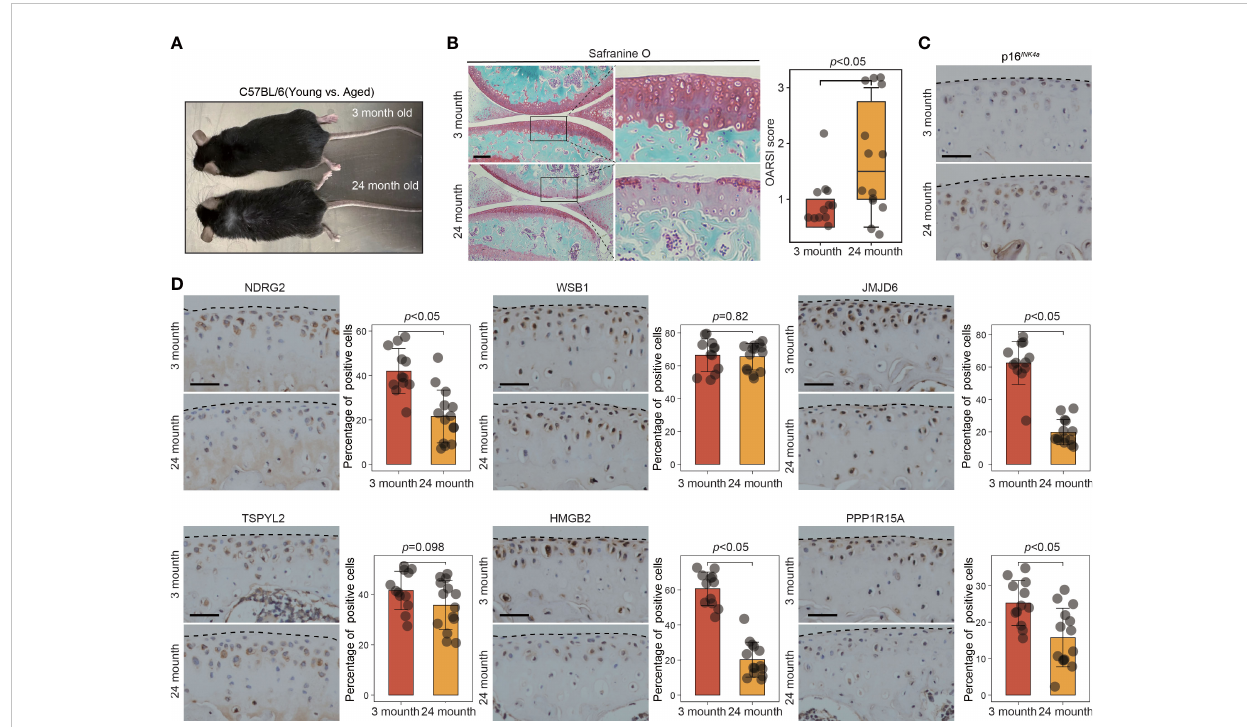
FIGURE 7 The expression of key leading-edge proteins in aged mouse model of OA. (A) Representative photograph of 3-month-old (n=12 per group) and 24- month-old mouse (n=14 per group). (B) Cartilage degeneration was determined by safranin O staining and evaluated by OARSI grade. (C) Representative images of immunohistochemical staining with antibodies against p16 INK4a in 3-month-old and 24-month-old mouse. (D) Representative images of immunohistochemical staining with antibodies against NDRG2, WSB1, JMJD6, TSPYL2, HMGB2 and PPP1R15A in 3-month- old and 24-month-old mouse. The right panels show the quanti fi cation of the immunohistochemical staining. The scale bar represents 50 m m. OARSI grade data are expressed as the interquartile range (from the 25th to the 75th percentiles), with the centerline corresponding to the median. IHC quanti fi cation data are expressed as the mean ± SD. Mann – Whitney U test was used for OARSI grade statistical analysis; Student ’ s t test was used for IHC quanti fi cation statistical analysis. p < 0.05 was considered statistically signi fi